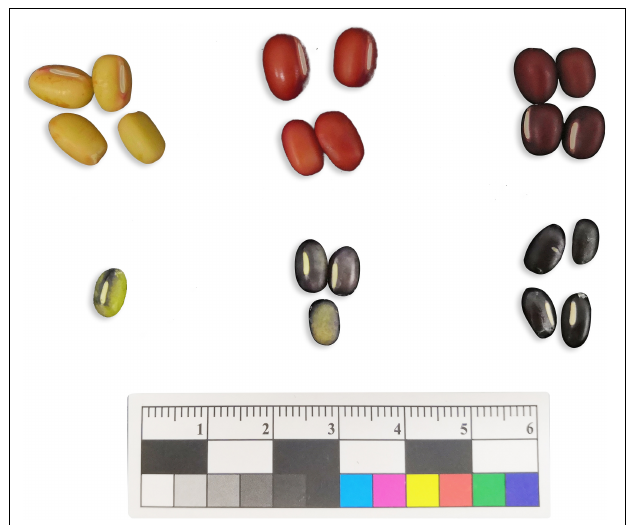
FIGURE 1 | Seed coat colouring degree of Jingnong6 and AG118 in different colouring